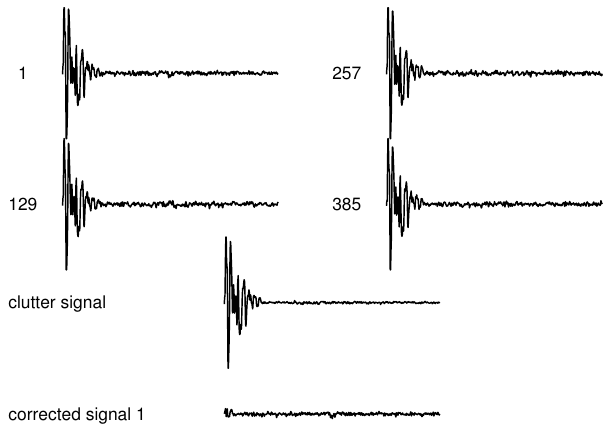
Fig. 1. Method for clutter suppression: numbered signals are clutter contaminated echoes of the same phase code. Due to the use of 64- bit alternating codes the same code is repeated after 128 transmis- sions. The clutter signal is produced by calculating a point-by-point average of the numbered signals. Because of the long correlation time of the clutter signal it is not averaged to zero as the true iono- spheric echoes do. The corrected signal is a clutter corrected version of signal number 1. It is produced by subtracting the clutter signal from the clutter-contaminated one. To make the clutter correction for signal 2 an average of signals 2, 130, 258 and 386 is subtracted from signal 2